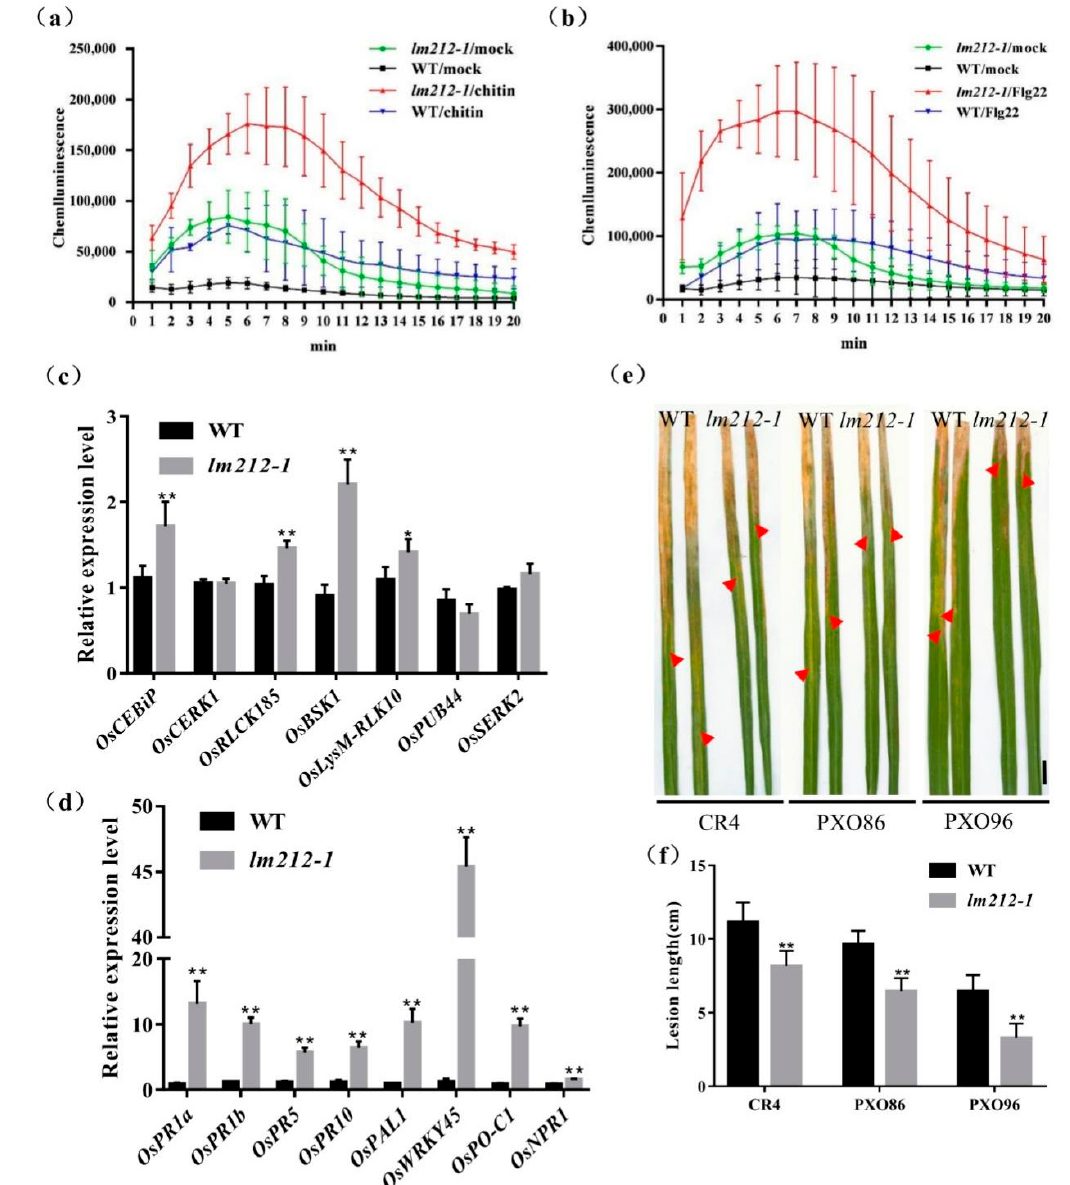
Figure 4. Identification of disease resistance. ( a – c ) ROS accumulation after mock (ddH 2 O), flg22, chitin treatments and expression levels of genes related to PTI response pathway. ( a ) ROS accumulation dynamics of WT, lm212-1 after chitin treatment. ( b ) ROS accumulation dynamics of WT, lm212-1 after flg22 treatment. ( c ) Expression analysis of PTI response-related genes in WT and lm212-1 at the tillering stage. ( d ) Expression analysis of defense response-related genes in WT and lm212-1. * p < 0.05 and ** p < 0.01 by the Student’s t -test. Data represent means ± SD of three biological replicates. ( e , f ) Detection of the resistance to bacterial blight Xoo . ( e ) Leaves of WT and lm212-1 after inoculation with CR4, PXO86, and PXO96. The red arrows represent the lesion length. Scale bars, 1 cm. ( f ) Lesion length of WT, lm212-1. ** p < 0.01 by the Student’s t -test. Data represent means ± SD of ten biological replicates.